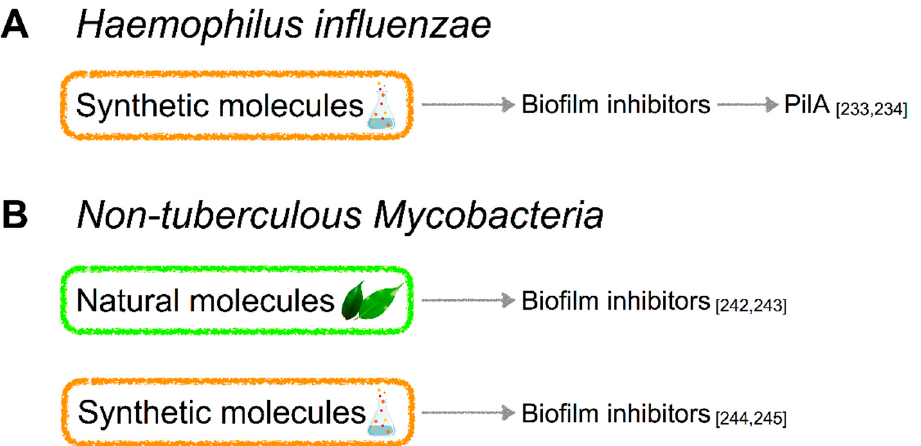
Figure 9 . Targets of natural and synthetic molecules active against Haemophilus influenzae ( A ) and Non-tuberculous Mycobacteria ( B ) quorum sensing.